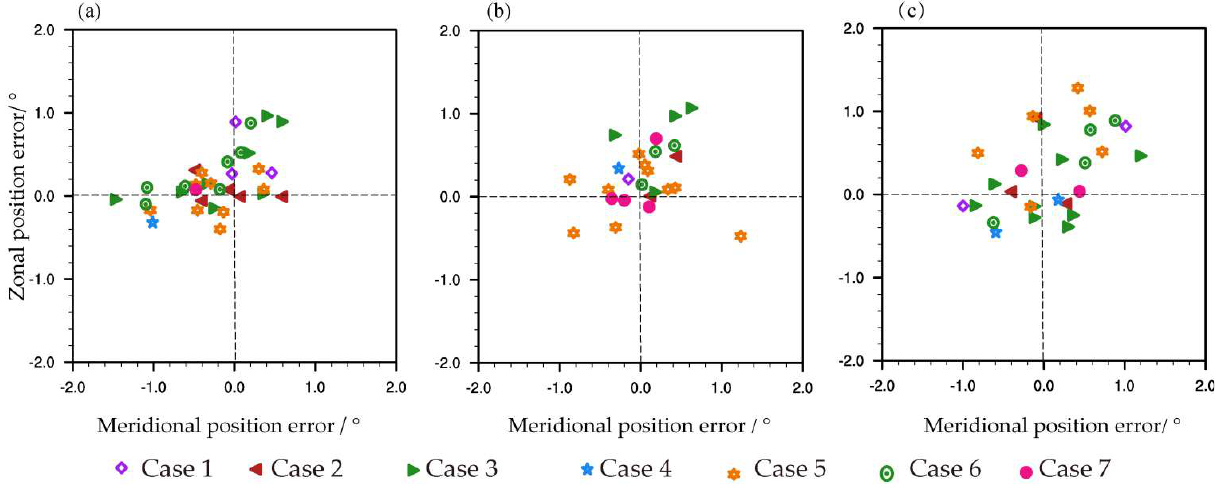
Figure 4. Comparison of the spatial position error and observation of the object tested by the spatial MODE method of the rainstorm weather process in seven rainstorms in 2020. ( a ) ECMWF, ( b ) SCMOC, ( c ) CMA−Meso.